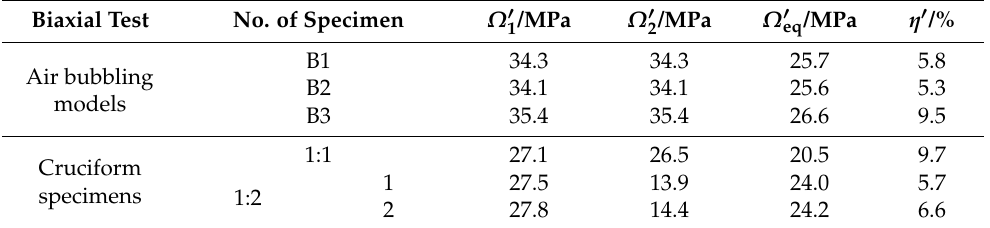
Table 8. The verification of Equation (16) using the data ( Ω (cid:48) 1 , Ω (cid:48) 2 and Ω (cid:48) eq ). Biaxial